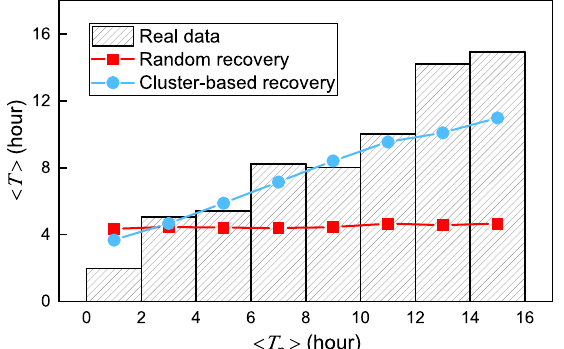
Fig. 5 | Comparison between the proposed cluster-based recovery, random recovery, and real data. The averagerecoveryduration of outages 〈 T 〉 versus that of theirgeographicallynearest n outages 〈 T n 〉 . The histogram isobtained from real outage data of a blackout that began on 25 February 2019 in Massachusetts. Each bar represents the average duration of outages whose nearest n outages' mean recovery time fall in the given duration interval. We set n = 5 as the results are insensitive to the choice of n (Supplementary Fig. S2). The curves shown are cor- responding simulation results of random recovery (red) and proposed cluster- based recovery